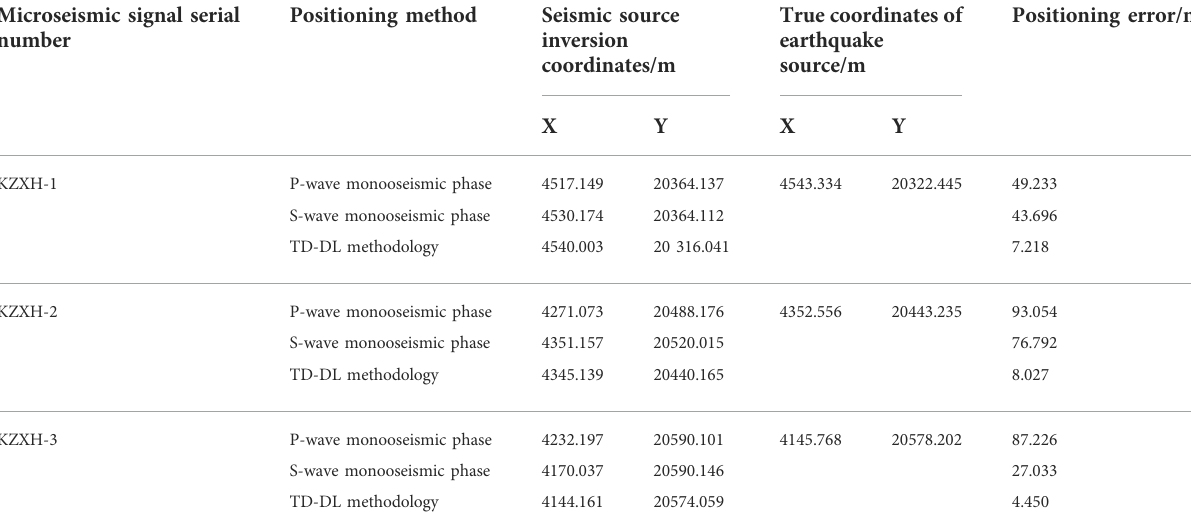
TABLE 9 Location results of each seismic phase in mine seismic signal.